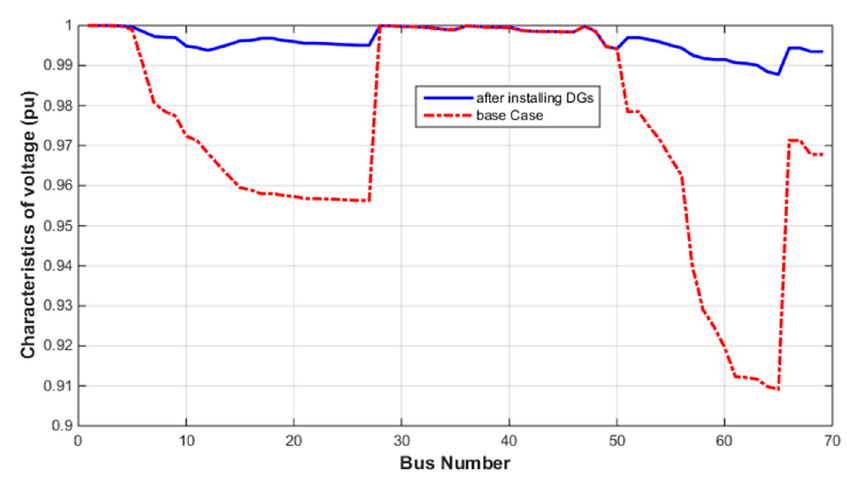
Figure 21. Characteristics of voltage, three DGs at unity pf.